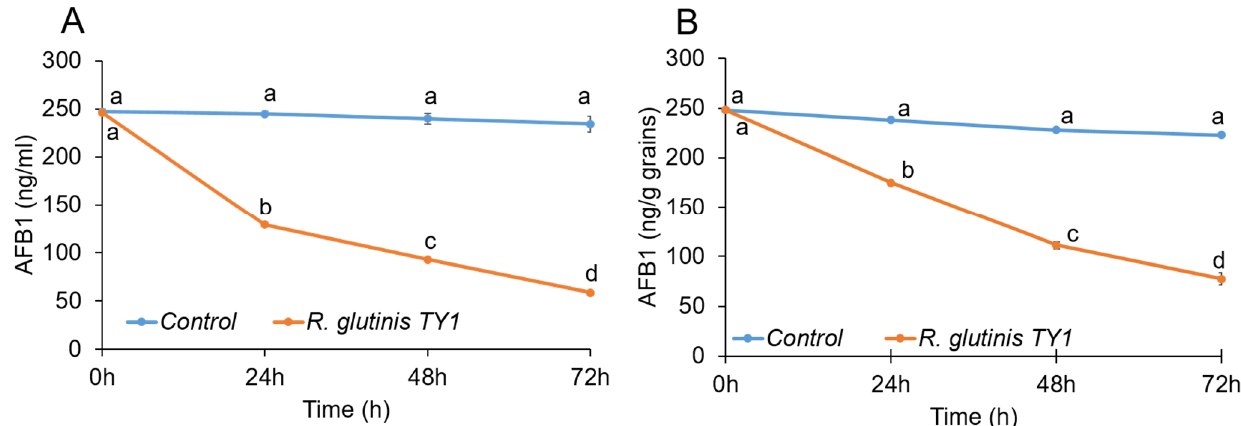
Figure 8. Effect of R. glutinis TY1 strain on AFB1 degradation in PDB medium ( A ) and wheat grains ( B ). The time course of AFB1 degradation was monitored by HPLC. Error bars represent the standard error of the mean (SEM) across three independent replicates. One-way ANCOVA was conducted to determine a statistically significant difference between treatment and control on mycotoxin concentration controlling for time (covariance). Time significantly differed in its effect on treatment and control ( p < 0.0001). Testing for each time point using ANOVA is an evident that only time zero does not differ between control and treatment. Different letters above the error bars indicate statistically significant differences at p < 0.05, as determined using the Duncan’s multiple range test.